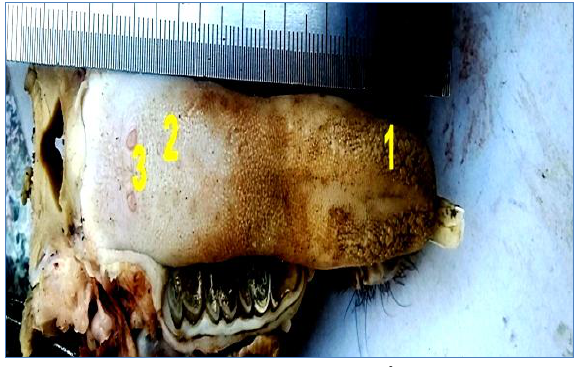
Figure, 4: Tongue papillae of Hystrix crestat showed: filiform (1) fungiform (2) circumvallate